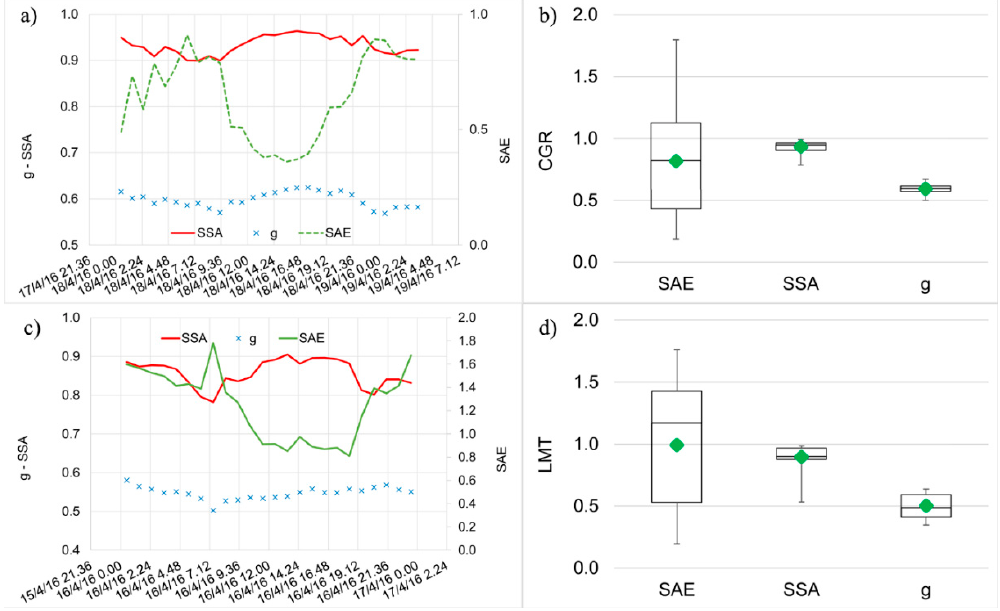
Figure 7. A time example for SAE, SSA, and g for a marine episode at ( a ) CGR, ( c ) LMT observatories (left side), respectively. Box and whiskers plots for SAE, SSA, and g for marine contribution selection at ( b ) CGR and ( d ) LMT. Horizontal black lines are the median value. Boxes represent the 25th and 75th percentile. Whiskers are min and max values. In green (diamond) are the average values for the three measured parameters.